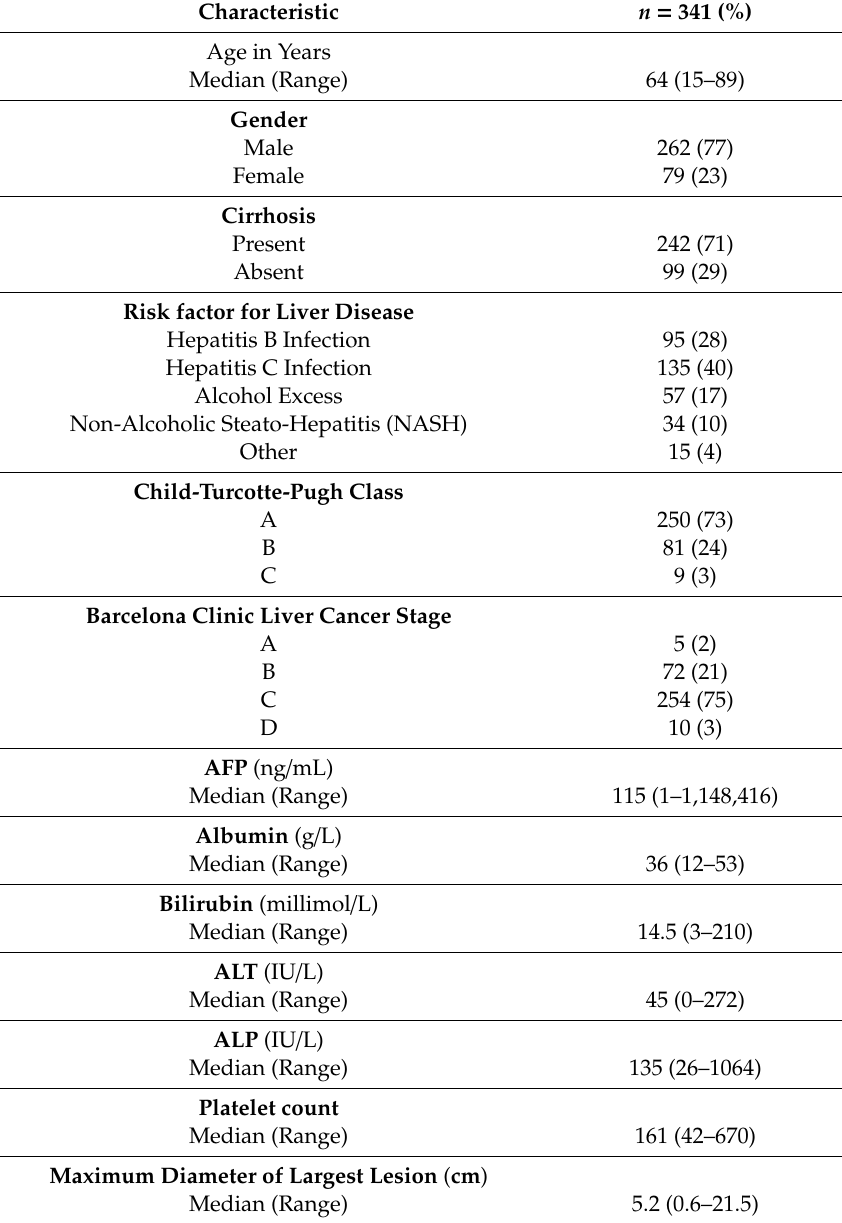
Table 1. Clinical characteristics of the studied patient